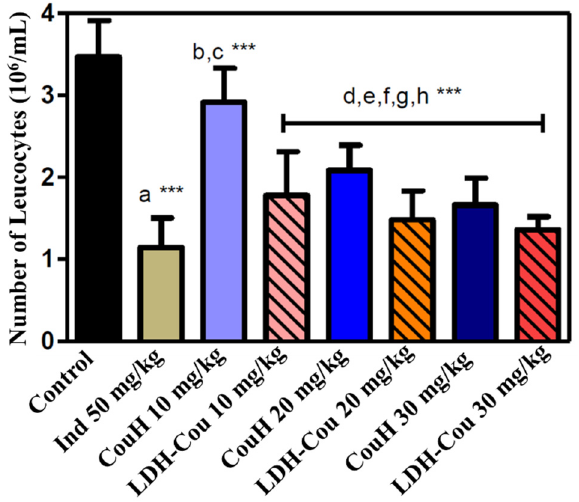
Figure 5. Number of leukocytes/mL at the pleural liquid post-treatment with CouH or LDH-Cou at 10, 20, and 30 mg/kg, compared to indomethacin (Ind, 50 mg/kg). Statistics: a—Ind 50 mg/kg vs. control; b—CouH 10 mg/kg vs. Ind 50 mg/kg; c—Cou-H 10 mg/kg vs. LDH-Cou 10 mg/kg; d—LDH-Cou 10 mg/kg vs. control; e—CouH 20 mg/kg vs. control; f—LDH-Cou 20 mg/kg vs. control; g—Cou-H 30 mg/kg vs. control; h—LDH-Cou 30 mg/kg vs. control.*** p < 0.001 (average ± SD, n = 7/group).